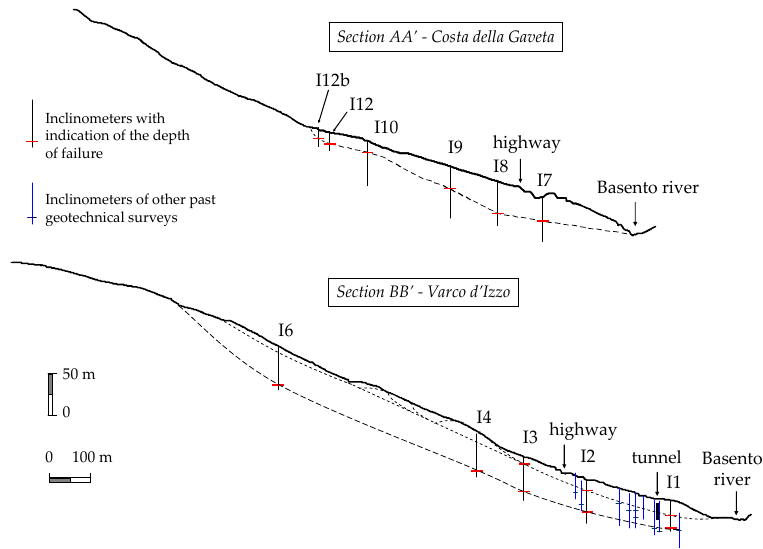
Figure 3. Sections AA’ and BB’ with inclinometers of recent and past surveys, depth of failures, and hypothesized slip surfaces.